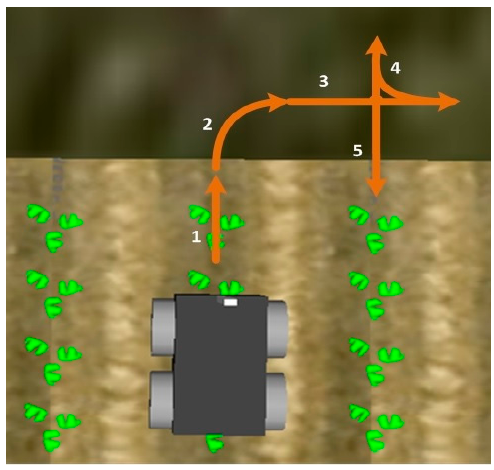
Figure 14. Manoeuvres defined for crop row change.